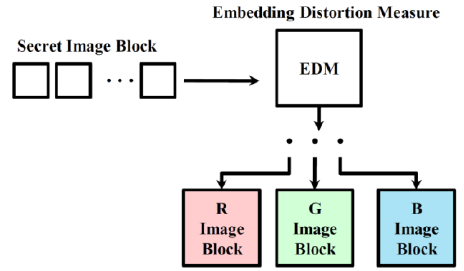
Fig. 3: Embedding Distortion Measure